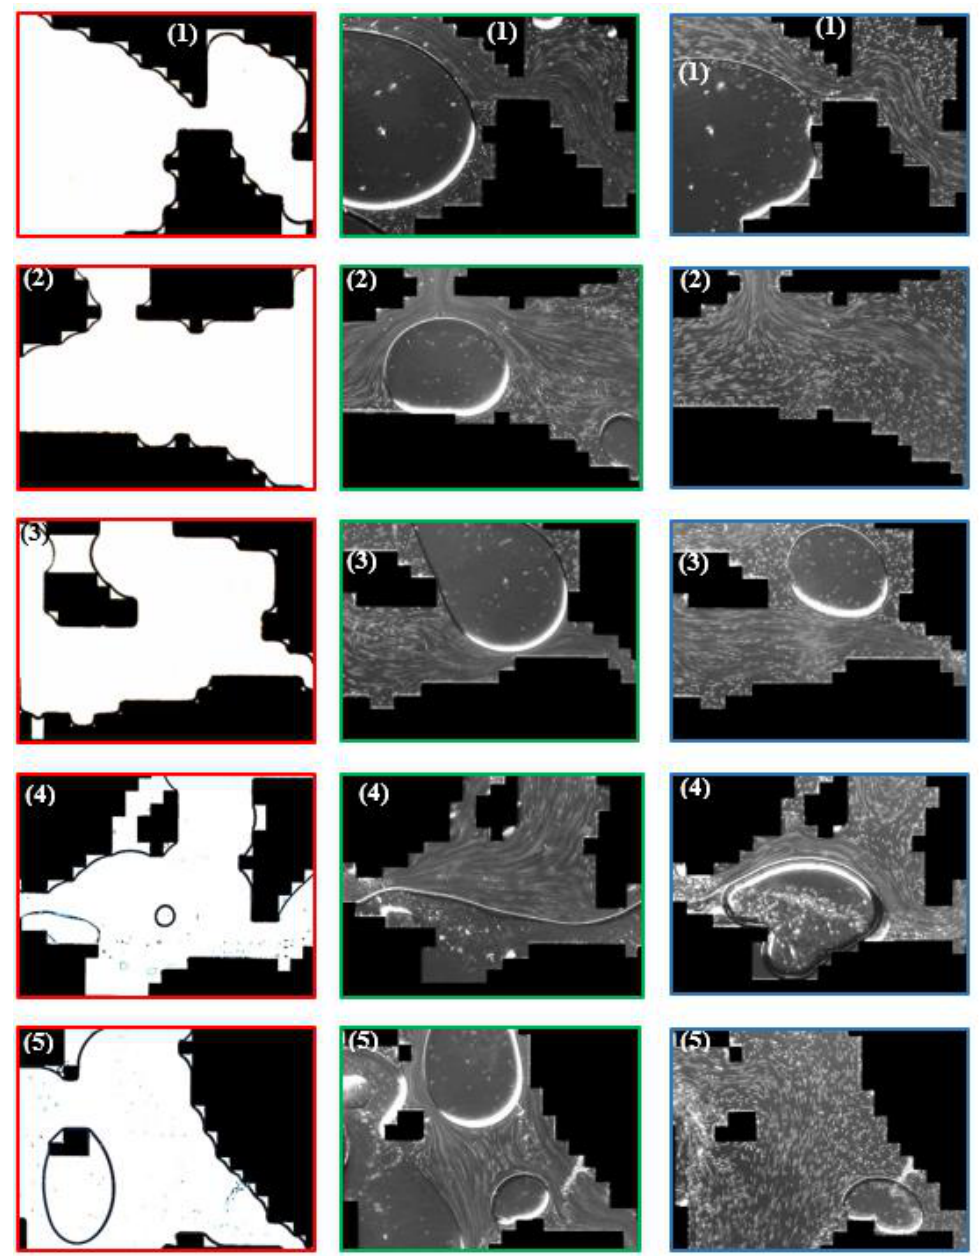
Figure 22. (Red) Binary images of the initial oil saturation in the selected pores. The images refer to the evaluation and analysis of a 500 ppm polymer solution at laminar flow conditions; (green) Streamline visualization during PEO flooding in the selected pores. The images refer to the evaluation and analysis of PEO (3350 ppm) at laminar flow conditions using an injection rate of 0.5 µL/min; (blue) Streamline visualization during 500 ppm polymer flooding in the selected pores. The images refer to the evaluation and analysis of the 500 ppm polymer solution at laminar flow conditions using an injection rate of 0.5 µL/min [11]. The initial oil saturations were determined for pores 1 to 5 to be 93.87%, 96.46%, 90.99%, 87.47% and 74.43%. Similar to the laminar flow regime experiment, a 6500 ppm non-viscoelastic PEO solution was injected (30 µL/min) resulting in S or from pores 1 to 5 of 45.38%, 28.07%, 36.39%, 34.7% and 58.69%.